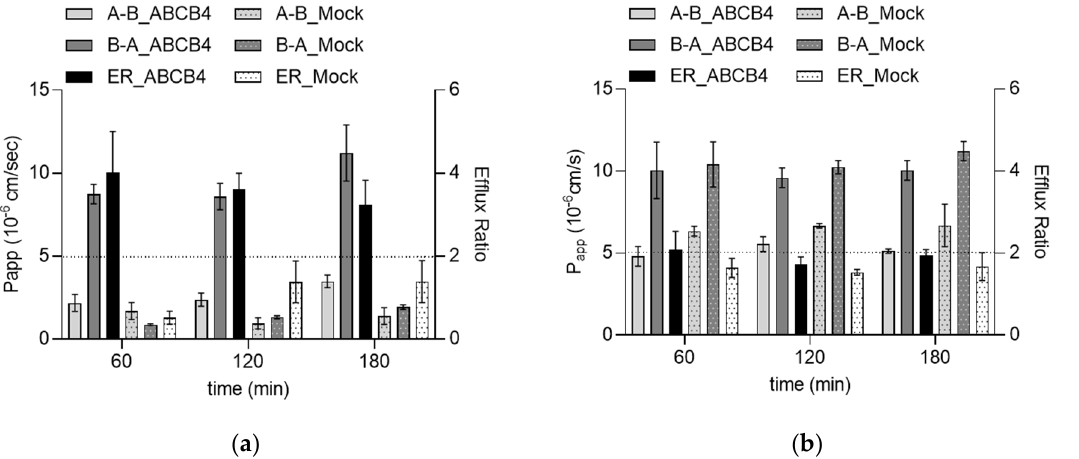
Figure 2. Transcellular transport of TKIs in the ABCB4 and Mock cells. ( a ) Bidirectional transport of gefitinib. ABCB4 and Mock cells were incubated with 0.5 µM gefitinib for 60, 120 or 180 min. Data are represented as means ± S.D. for three experiments. Gefitinib concentration in the samples was determined with LC-MS/MS. ( b ) Bidirectional transport of imatinib. ABCB4 and Mock cells were incubated with 0.5 µM imatinib for 60, 120 or 180 min. Imatinib concentration in the samples was determined with LC-MS/MS. Data are represented as means ± S.D. from three independent experiments.